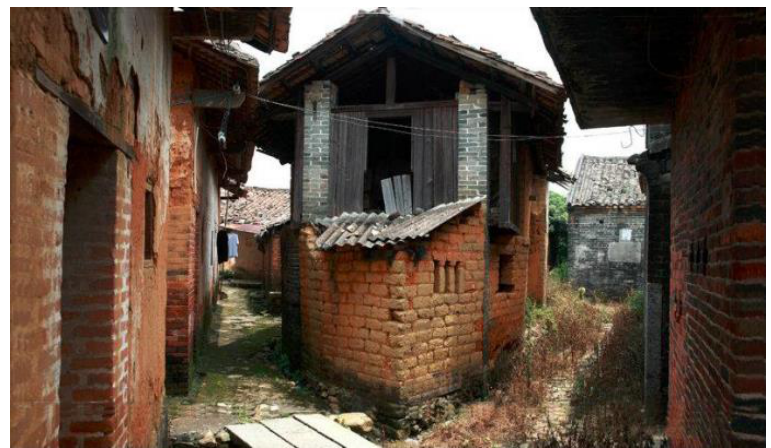
Figure 15. Special construction (source: the authors).